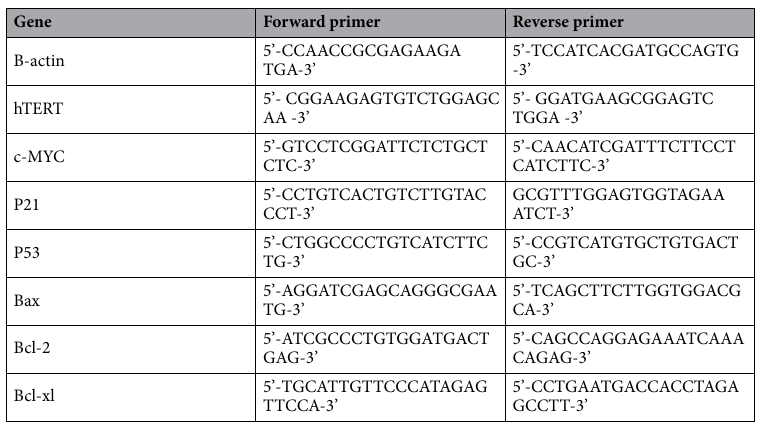
Table 3. Primer sequences used for quantitative real-time